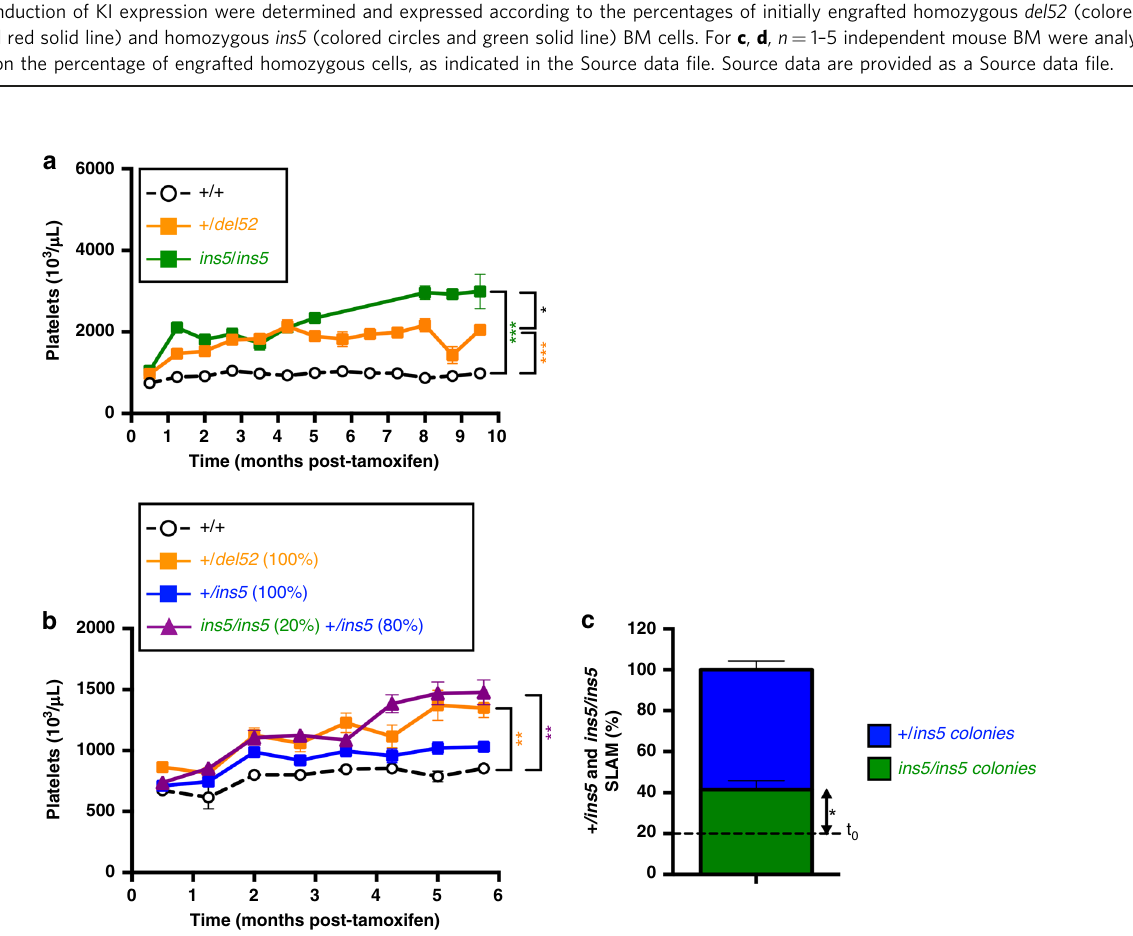
Fig. 8 Homozygous ins5 cells drive the severity of the disease phenotype. a Comparison of the time-dependent increase in blood platelet levels of heterozygous + /del52 (orange squares and solid line) and homozygous ins5/ins5 (green squares and solid line) KI mice after tamoxifen induction. Means ± SEM ( n = 16, 18, 15, 11, 11, 8, 13, 7, 14, 11, 5, 6, 4 + / + , n = 18, 20, 15, 12, 10, 7, 11, 7, 12, 12, 8, 5, 10 + /del52 and n = 6, 1, 6, 8, 9, 7, 5, 6, 5, 5 ins5/ins5 independent mice, as shown in the Source data fi le) and signi fi cance was determined using ANOVA with Tukey ’ s multiple comparison test (* p = 0.0365; *** p < 0.001). To investigate the effect of homozygous ins5/ins5 cells in the development of thrombocytosis we engrafted 20% of ins5/ins5 KI BM cells with 80% of heterozygous + /ins5 KI BM cells in lethally irradiated mice (purple triangles with solid line). As controls we also engrafted 100% wt ( + / + , open circles with black solid line), heterozygous + /del52 orange squares with solid line) or + /ins5 (blue squares with solid line) KI BM cells. Four weeks after transplantation, KI allele expression was induced by tamoxifen and b platelets were measured. Figure shows the means± SEM ( n = 6 + / + n = 8, 8, 8, 8, 7, 8, 8, 8 + /del52 , n = 8 and 7 for the last point + /ins5 and n = 8, 8, 8, 8, 3, 8, 7, 7 ins5/ins5 and + /ins5 mixed individual mice, as indicated in the Source data fi le). Signi fi cance was calculated with a nonparametric Kruskal – Wallis ’ s multiple comparison test (** p = 0.0076 ( + / + vs. 20% ins5/ins5 ), 0.0083 ( + / + vs. 100%. + /del52 ). c At 6 months post-induction, single BM SLAM were sorted for a 10-day culture with all cytokines. Colonies were genotyped to retrospectively identify percentages of ins5/ins5 (green) and + /ins5 (blue) SLAMs. Data are the means ± SEM ( n = 3 mice with an average of 58 genotyped colonies/mouse). Signi fi cance compared to the 20% of initially engrafted ins5/ins5 BM cells (dashed line, t 0 ) was measured with a two-sided parametric t -test (* p = 0.0492). Source data are provided as a Source data fi